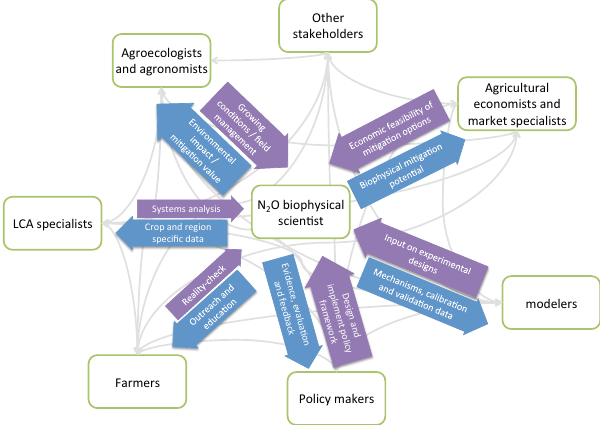
Figure 2. Stakeholder map with examples of knowledge exchange, interactions and opportunities for active collaborations between bio- physical scientists in N 2 O research and specialists in other disci-